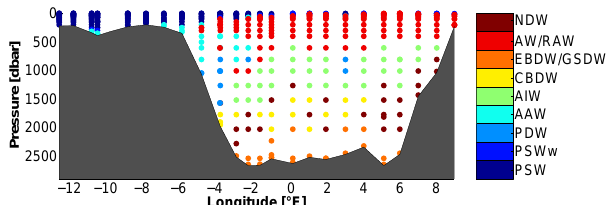
Figure 2. Water masses in the Fram Strait: Nordic Seas Deep Water (NDW), Atlantic Water/Recirculating Atlantic Water (AW/RAW), Eurasian Basin Deep Water (EBDW)/Greenland Sea Deep Water (GSDW), Canadian Basin Deep Water (CBDW), Arctic Intermedi- ate Water (AIW), Arctic Atlantic Water (AAW), Upper Polar Deep Water (uPDW), Polar Surface Water warm (PSWw) and Polar Sur- face Water (PSW).